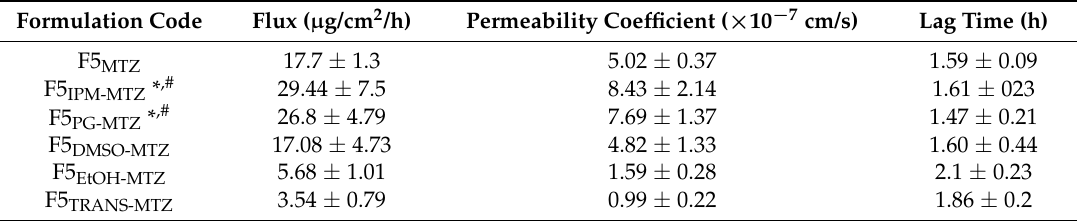
Table 3. Fluxes, permeability coefficients, and lag times of the Pal-GH gel formulations. Formulation Code Flux ( µ g/cm 2